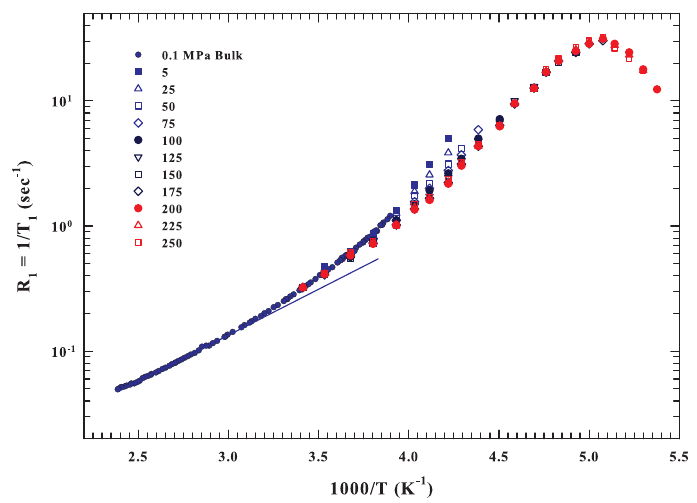
Figure 4. The different water proton relaxation rate ( R 1 = 1/ T 1 ) isobars, measured in the pressure range 0.1–250 MPa [22], are proposed in an Arrhenius